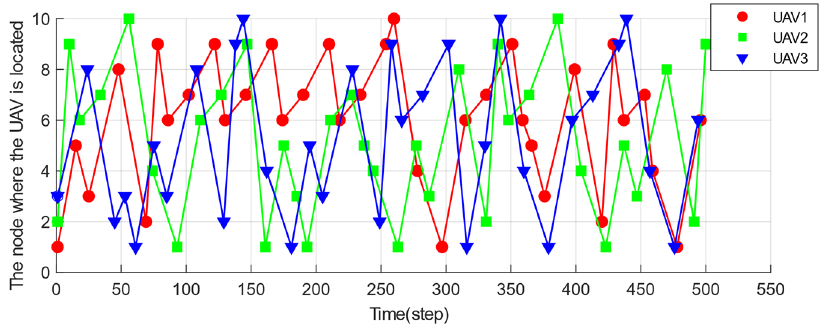
Figure 6. The persistent monitoring path obtained by ACO algorithm.